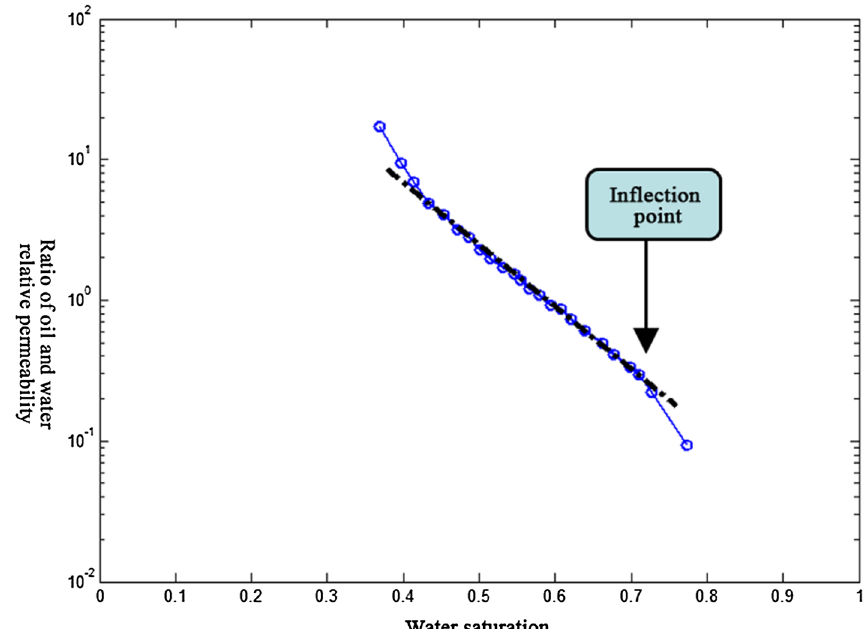
Fig. 1 Relation curve of water saturation and ratio of oil and water relative permeability